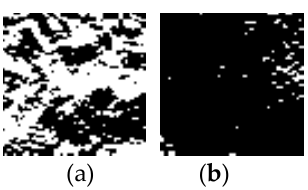
Figure 14. The detection image of the iris part and the detection image of the non-iris part. ( a ) Detection image of iris area, ( b ) detection image of non-iris area.